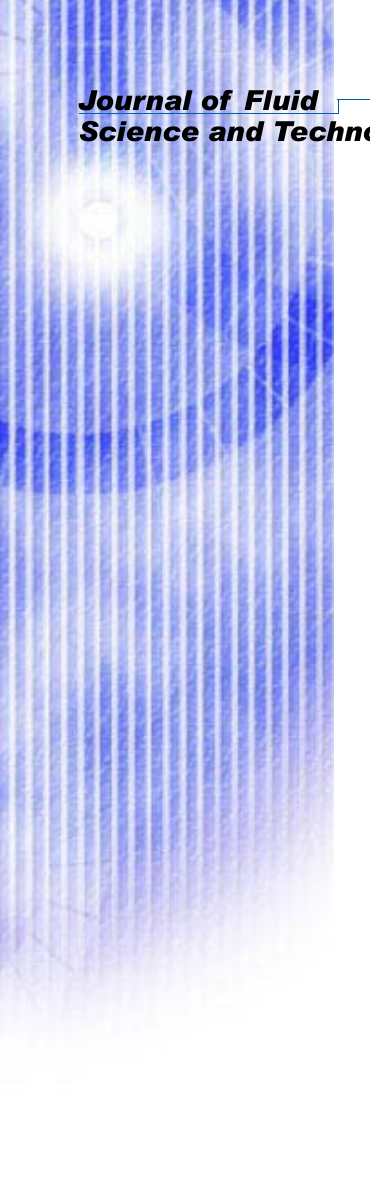
Fig.6 Spectra of blade stress fluctuation for various flow coefficients in the case of s =30mm, 3000rpm